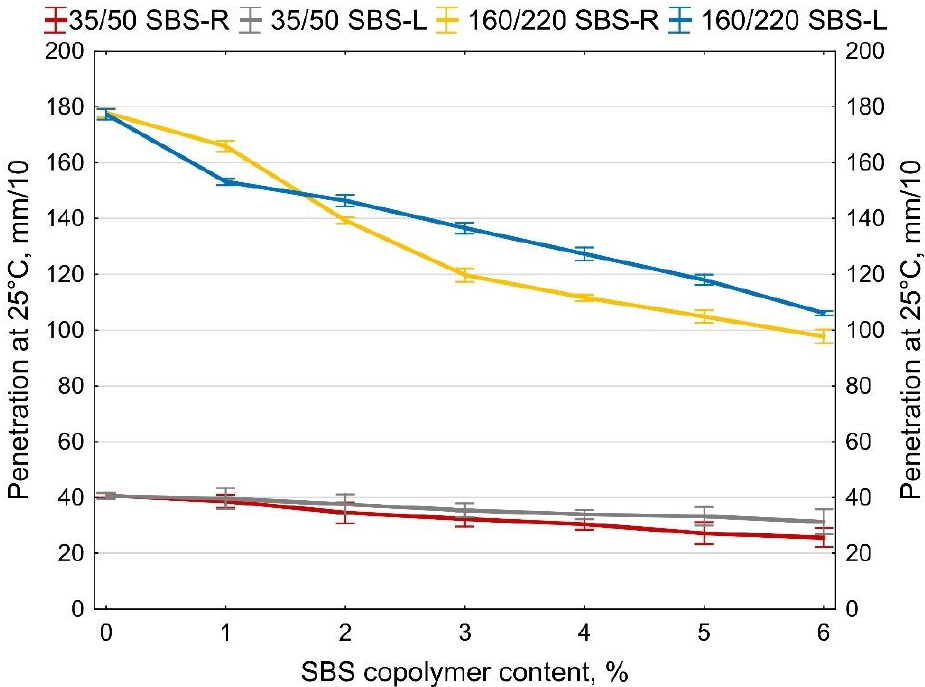
Figure 8. Penetration at 25 °C of SBS-modified bitumens, error bars show a 95% confidence interval for the mean.